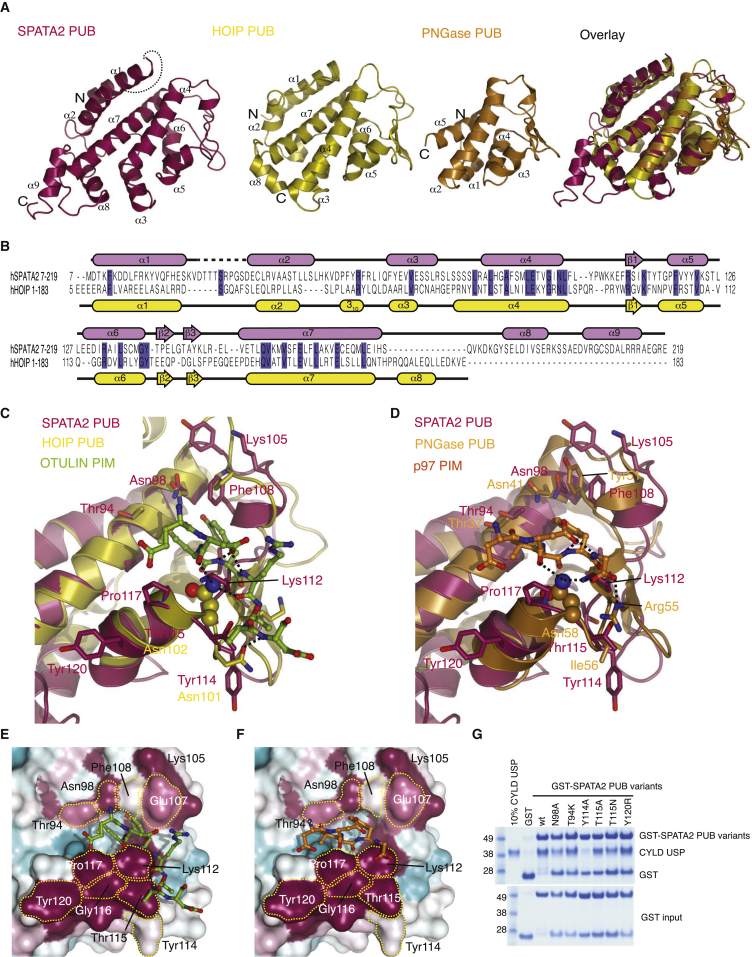
Structure of the SPATA2 PUB Domain(A) Far left, structure of the SPATA2 PUB domain (residues 7–219). Left, structure of the HOIP PUB domain (residues 1–184, PDB: 40YJ). Right, structure of the PNGase PUB domain (residues 12–110, PDB: 2HPJ). Far right, superimposition of all PUB domains on the α4, α7 core helices.(B) Structure-based sequence alignment of SPATA2 and HOIP PUB domains.(C) Superposition of SPATA2 onto HOIP PUB bound to OTULIN PIM (PDB: 40YK, PIM in green). Asn102, important for OTULIN PIM binding, is shown in a ball-and-stick model.(D) Superposition of SPATA2 and PNGase PUB bound to p97 PIM (PDB: 2HPL).(E and F) Conservation analysis of the SPATA2 PIM pocket (purple, conserved; white/cyan, not conserved). PIM peptides from OTULIN (E) and p97 (F) are modeled, revealing significant clashes.(G) Pull-down using GST-SPATA2 PUB domain and mutants within the PIM pocket against the CYLD USP domain.Also see Figure S2.